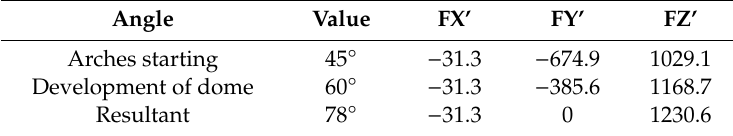
Table 3. Components of the reaction in di ff erent